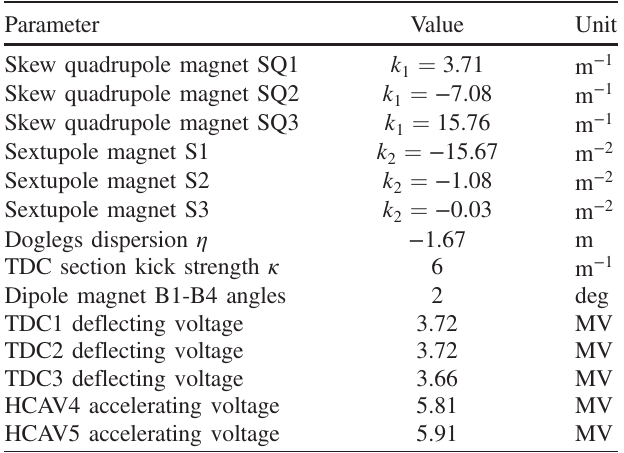
TABLE III. Operating parameters RFBT and EEX beamline, the magnet names refer to Fig. 2. The magnetic-field strength follows the convention k l ≡ ð ∂ l B x Þ = ð ∂ y l Þ .